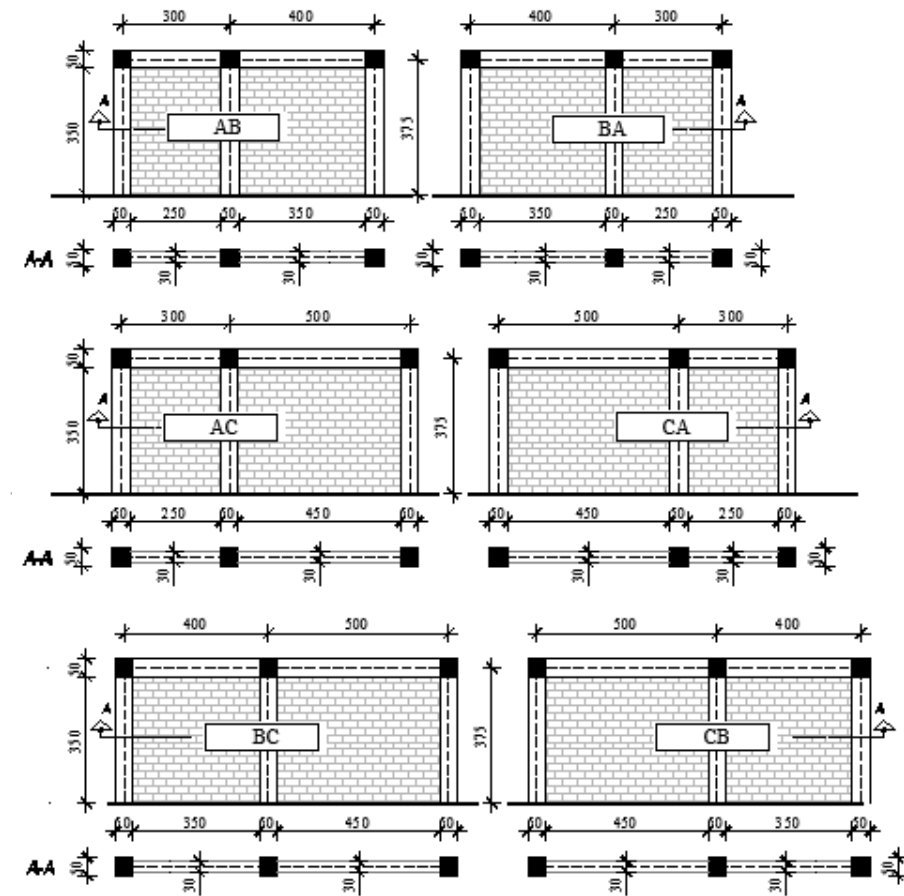
Figure 9. Infilled frame models—multi-bay models with di ff erent bay length.